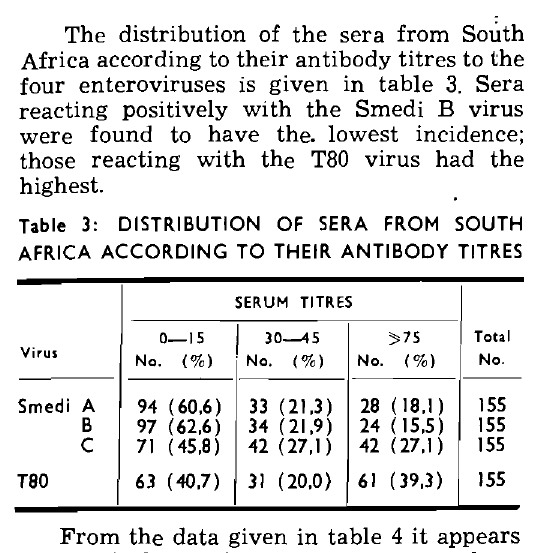
Table 5: DISTRIBUTION OF SERA FROM RHODESIA ACCORDING TO THEIR ANTIBODY TIT